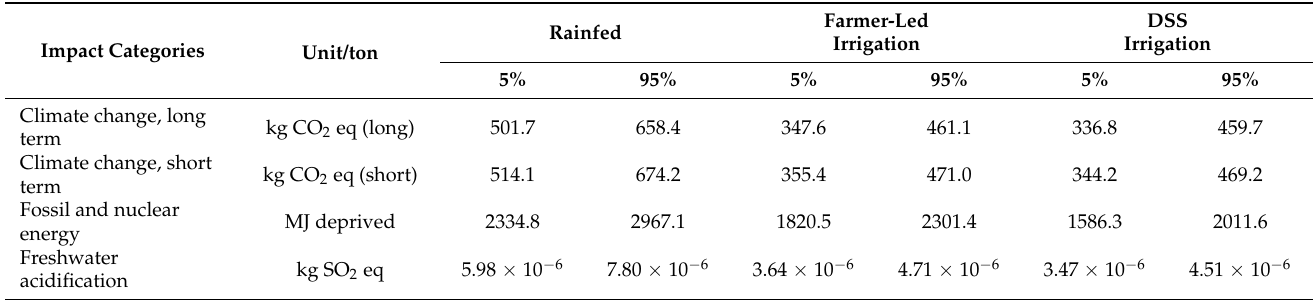
Table A4. Results of the uncertainty analysis with use of the Monte Carlo